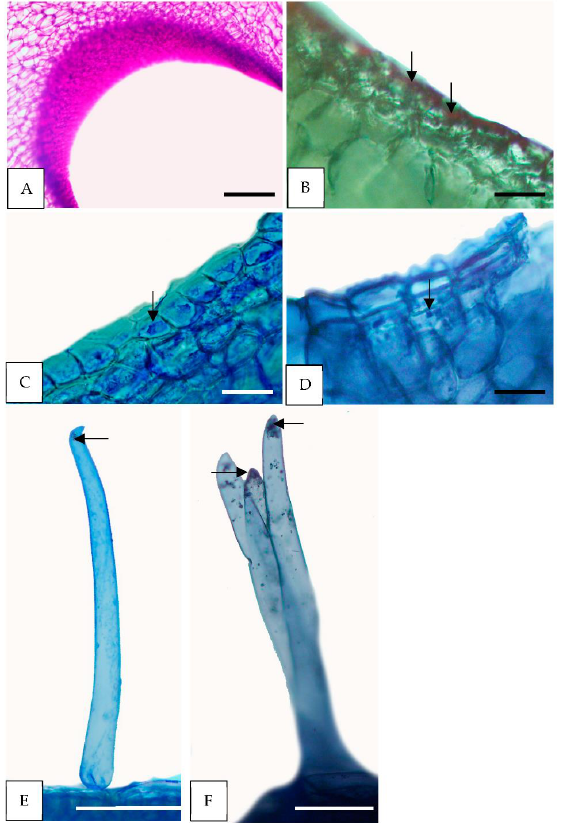
Figure 6. Histochemical tests of the floral glands of H. coriacea . ( A – D ) Secondary nectaries ( sn ). ( E , F ) Falcate trichomes ( ft ). ( A ) Polysaccharides stained pink in the nectariferous tissue composed of epidermis and parenchyma of sn (PAS); ( B ) few starch grains (arrows, IKI). ( C , E ) the epidermal and subepidermal layers of sn and ft with proteins (arrows, CB); ( D , F ) note numerous blue-black lipid droplets (arrows, SBB). PAS = periodic acid-Schiff reaction; IKI = Lugol’s reagent; CB = Commassie Blue; SBB = Sudan Black B. Scale: ( A , E , F ) = 200 µm; ( B – D ) = 50 µm.